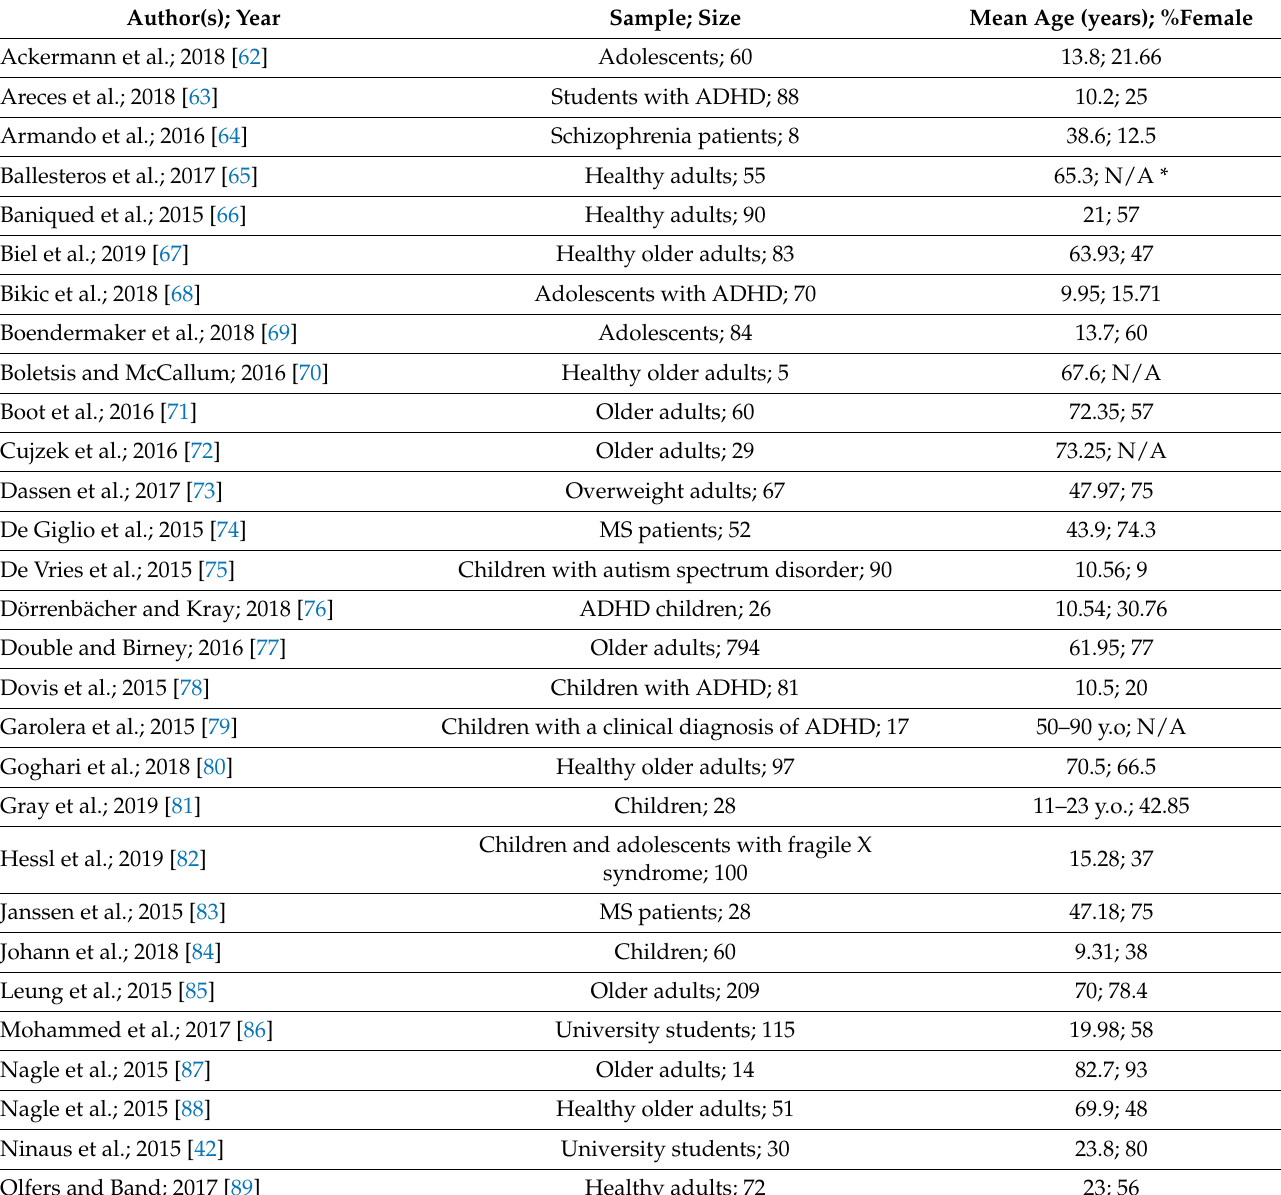
Table 1. Summary of studies included in the systematic